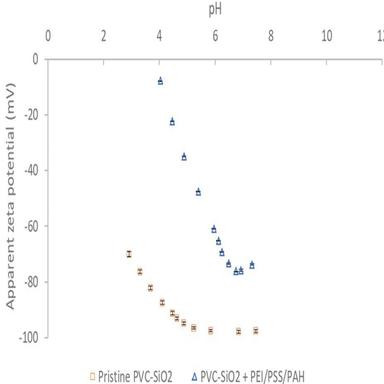
Apparent zeta potential of the unmodified and PEI/PSS/PAH modified PVC-SiO2 membranes versus pH for hch = 98 ± 1 µm; Solution: 0.001 M KCl.